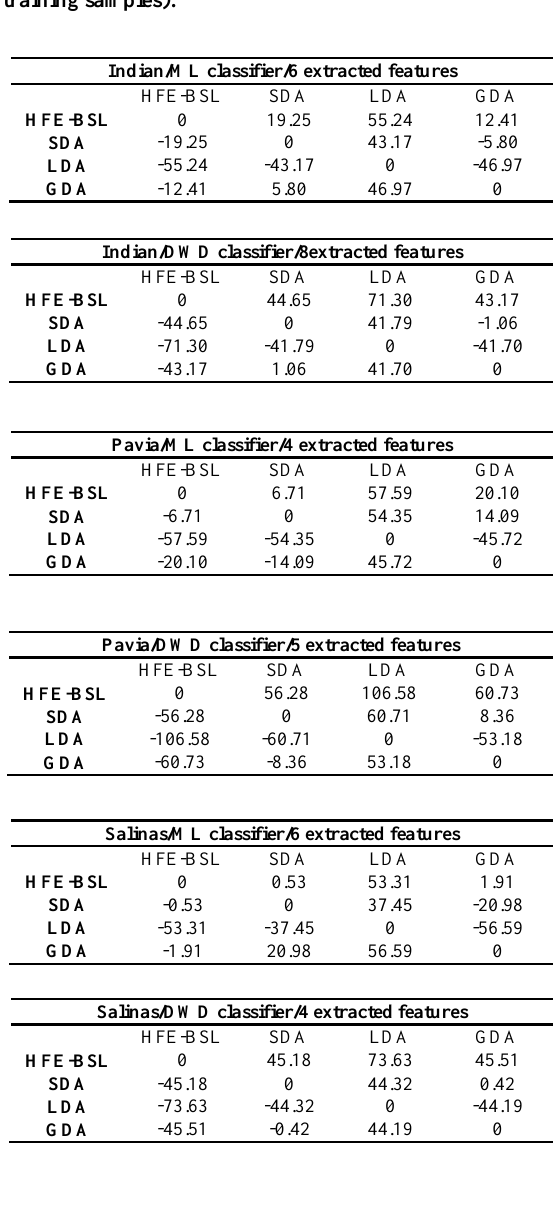
Table 5. Statistical significance of differences in classification ( ) . Each case in table represents , where is row and is column (all tables obtained by 16 training